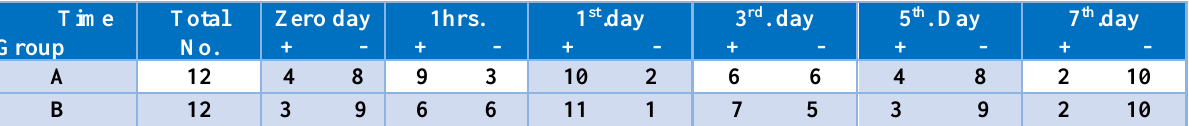
There is absence of differences in the mean values between the different groups and